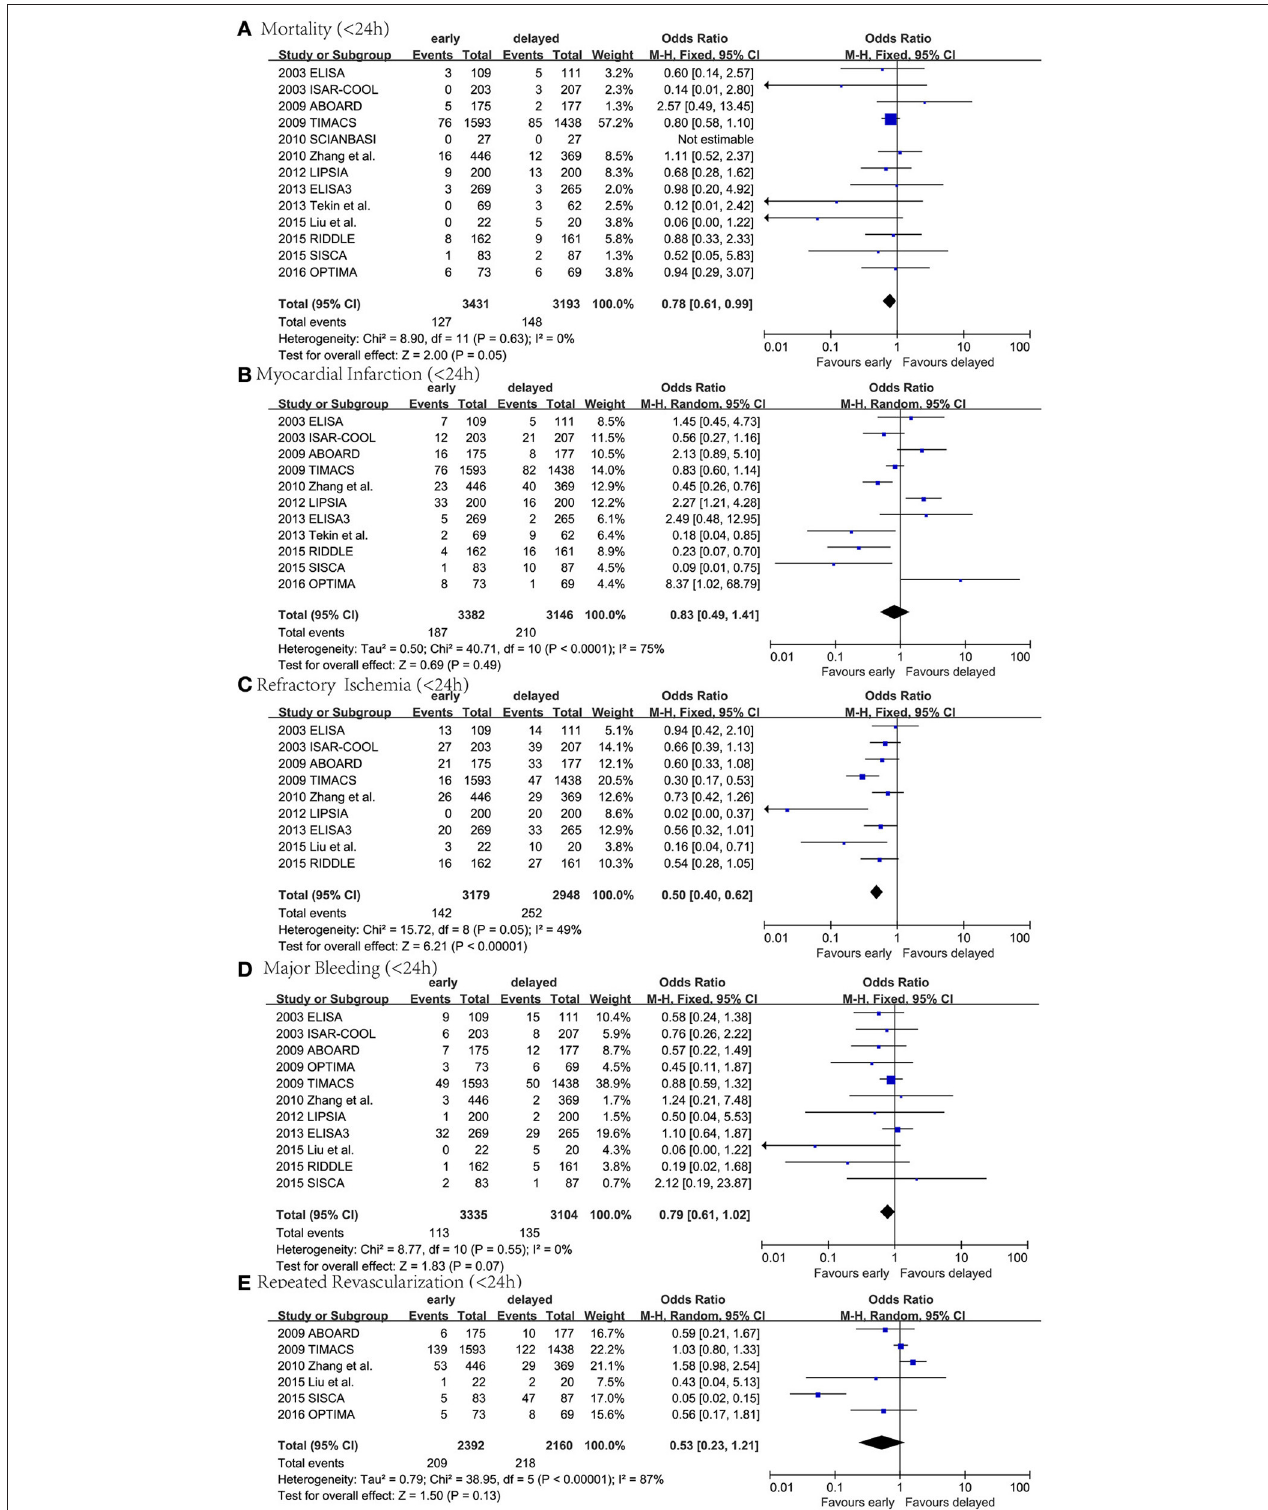
FIGURE 5 | Forest plots comparing outcomes between early ( < 24h) invasive group and delayed invasive group. (A) Mortality, (B) myocardial infarction, (C) refractory Ischemia, (D) major bleeding, and (E) repeated revascularization.